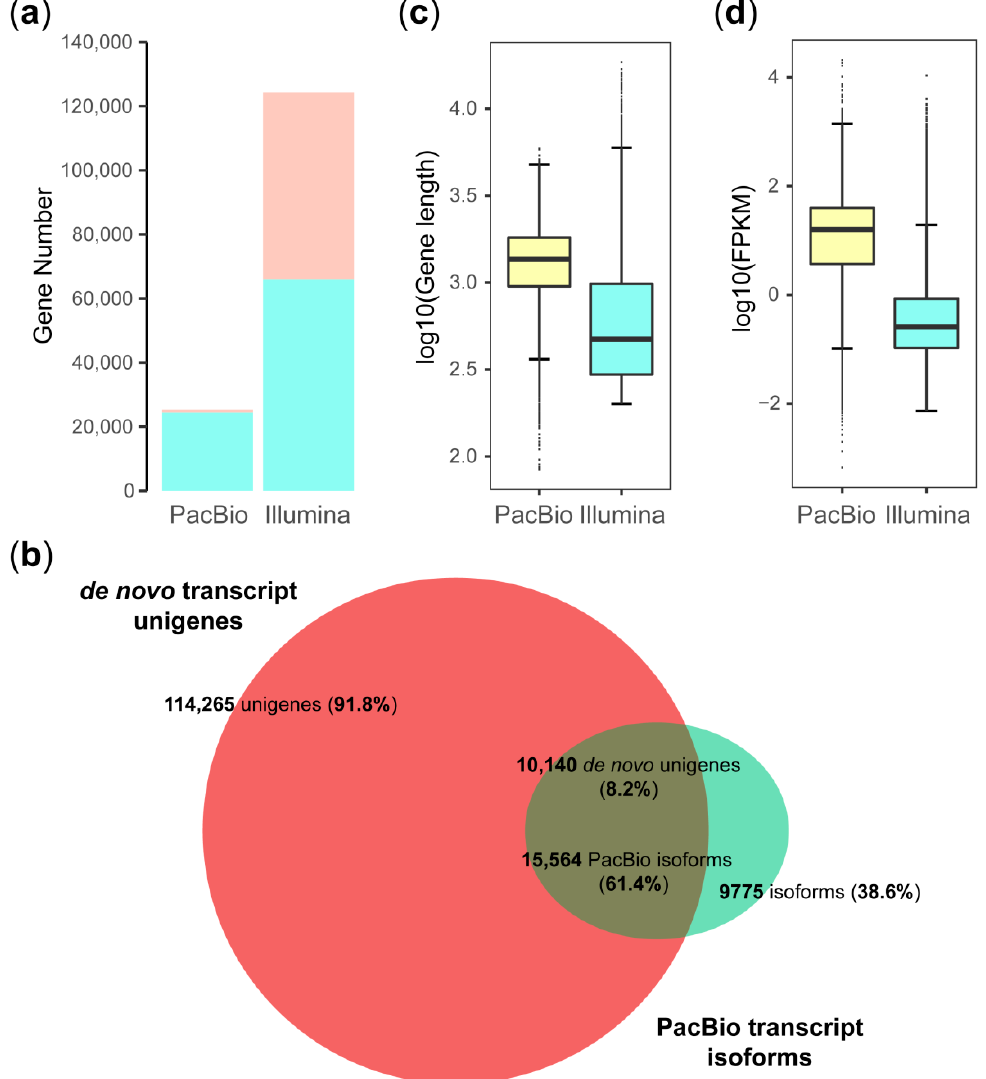
Figure 3. Comparison of PacBio and Illumina data. ( a ) The number of transcripts detected by PacBio and Illumina. ( b ) Comparison between the M. pasquieri PacBio transcript isoforms and de novo transcript unigenes. ( c ) Boxplot showing the length of transcript isoforms in PacBio and transcript unigenes in Illumina. ( d ) Boxplot showing the expression level of transcript isoforms in PacBio and transcript unigenes in Illumina.